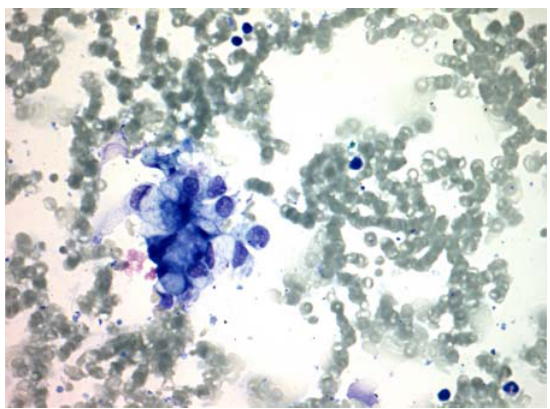
FIGURE 3. Fine needle biopsy of a supraclavicular lymph node showing numerous polygonal cells in a multilayered aggregate that possess intracytoplasmic vacuoles. Signet ring cells are created by a large, single vacuole with the enlarged nucleus pushed to the cell periphery. Giemsa stain 400x.